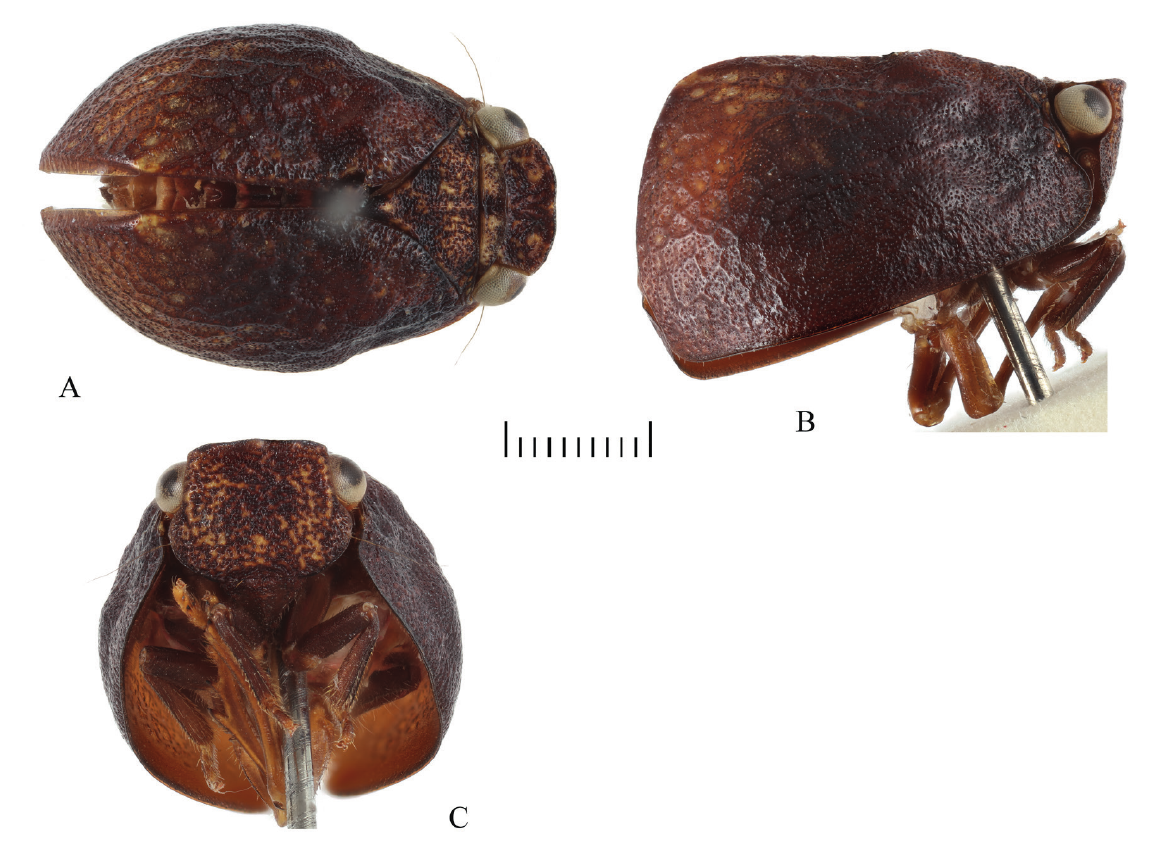
Fig. 2. Superciliaris celebensis sp. nov., ♂, holotype (BMNH), external view. A . Dorsal view. B . Lateral view. C . Frontal view. Scale bar = 1